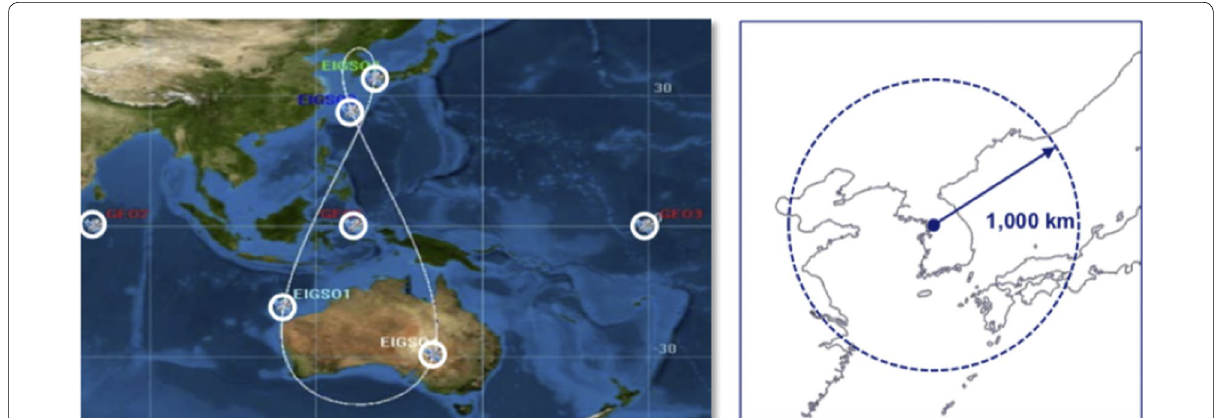
Fig. 5 The Regional South Korean Positioning System (KPS)—Constellation and Target Area. Reference: Moonbeom